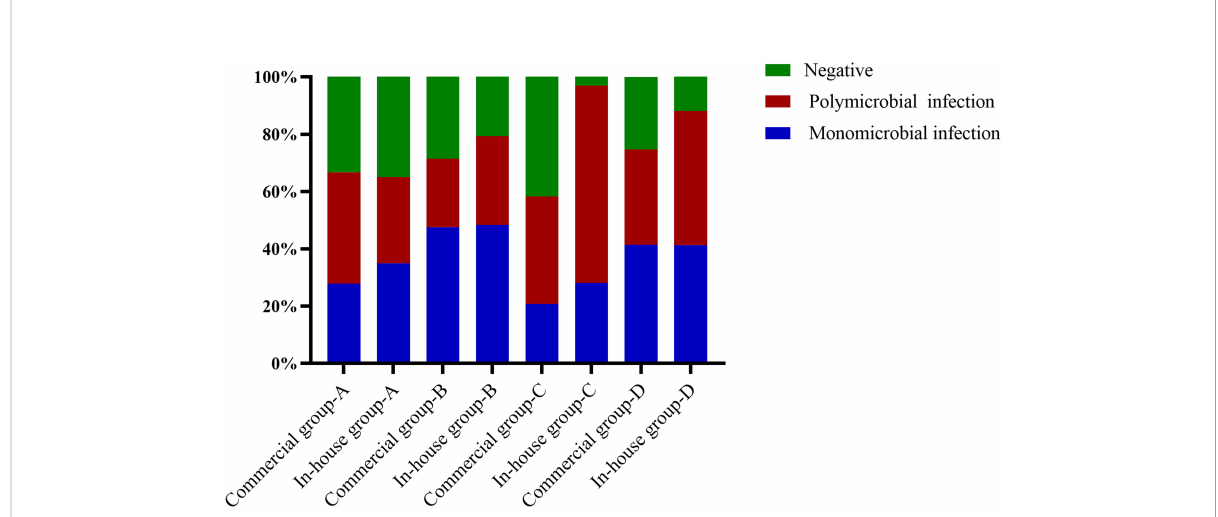
FIGURE 5 Proportions of polymicrobial and monomicrobial infections and negative cases of pulmonary infection detected using metagenomic next- generation sequencing (mNGS) in patients with different underlying diseases. (A) Simple pulmonary infection group. (B) Chronic airway infection group. (C) Immunocompromised group. (D)